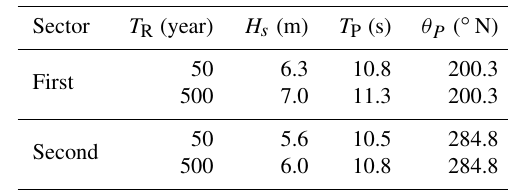
Table 2. Design wave parameters for the directional sectors. T R is the return period; H s , T P and θ P stand for wave height, period and incoming direction